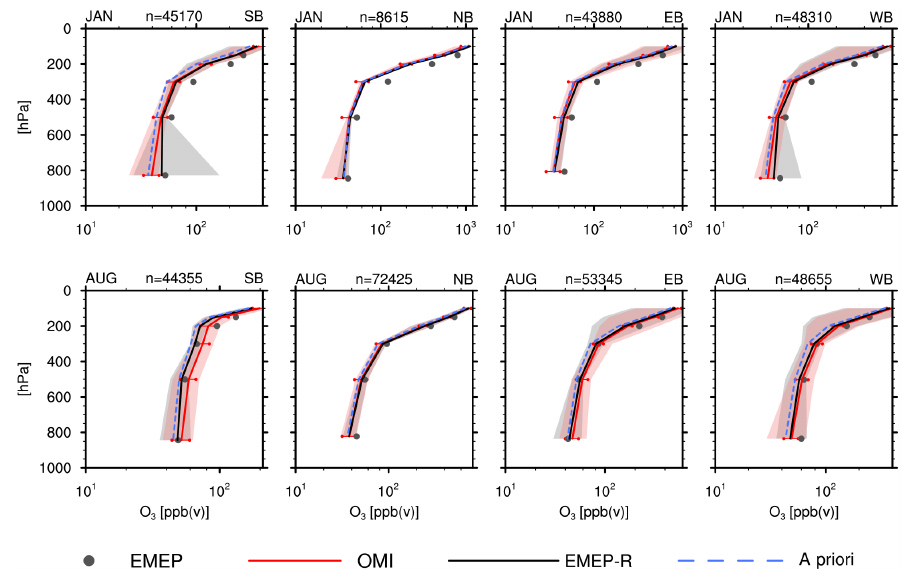
Figure 4. Same as Fig. 2 but for ozone and the satellite retrievals from OMI.